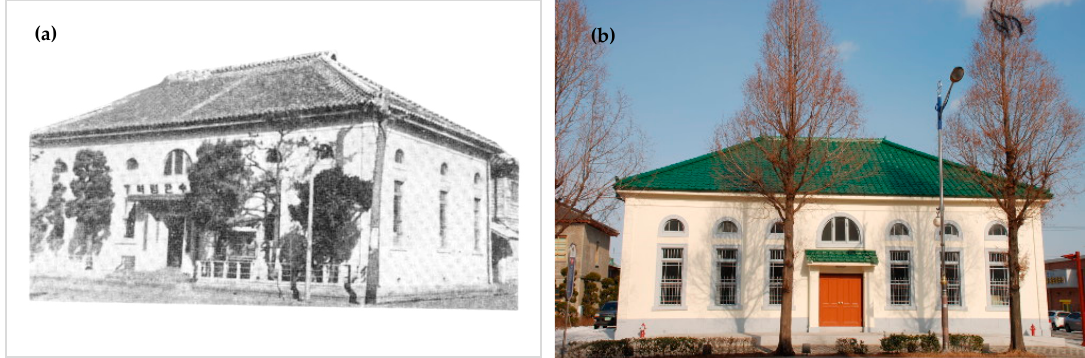
Figure 3. ( a ) Gunsan’s former branch of Japanese 18th Bank, 1907. ( b ) Museum of Modern Art, opened in 2013 after restoration (©Gunsan City).